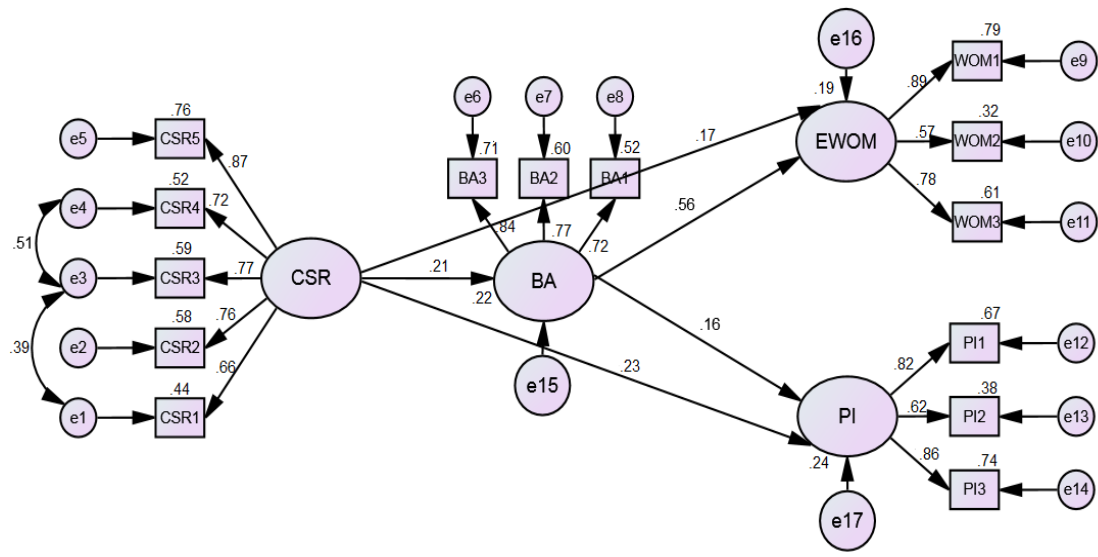
Figure 3. The structural model. Table 4. Results of hypotheses testing.